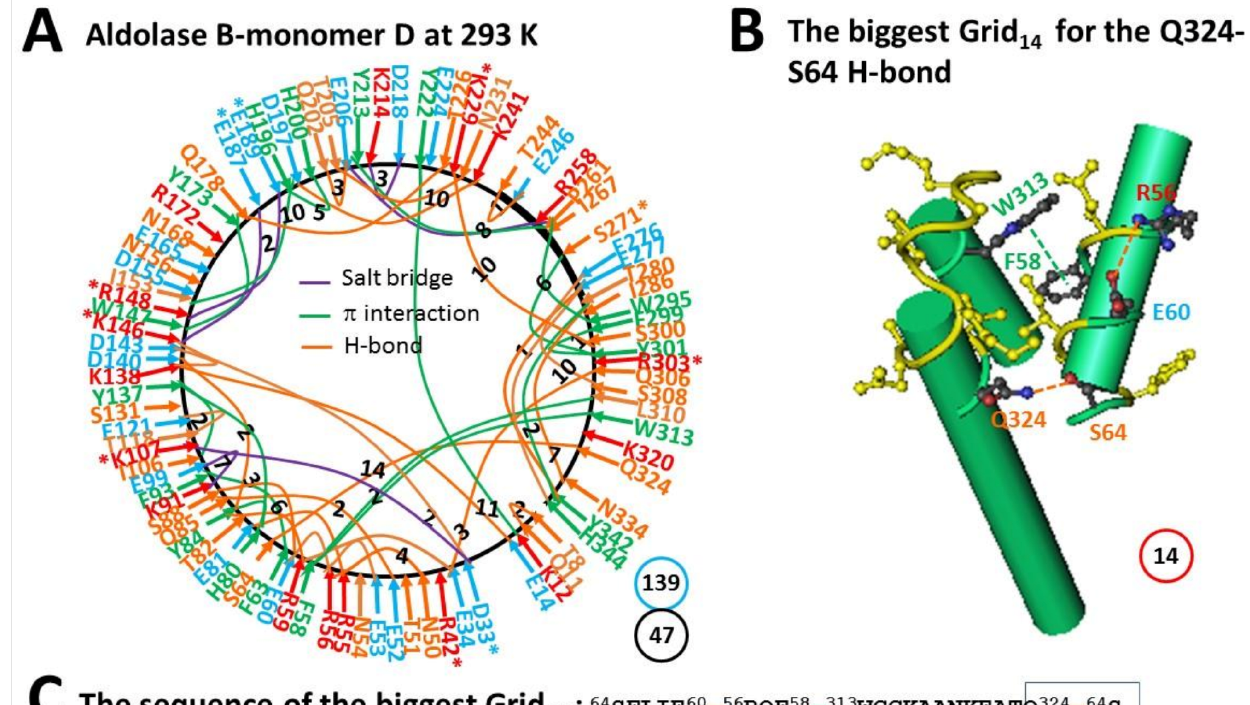
Figure 5. The grid-like non-covalently interacting mesh network along the single polypeptide chain of ligand-free monomer D in the aldolase B tetramer at room temperature (293 K). ( A ) The topological grids in the systemic fluidic grid-like mesh network. The X-ray crystallographic structure of monomer D in aldolase B at room temperature (293 K) (PDB ID, 1QO5) was used for the model [9]. Salt bridges, π interactions, and H-bonds between pairing amino acid side chains along the single polypeptide chain from Q9 to S352 are marked in purple, green, and orange, respectively. The grid sizes required to control the relevant non-covalent interactions were calculated and labeled in black. The total grid sizes and grid size-controlled non-covalent interactions along the single polypeptide chain are shown in the blue and black circles, respectively. ( B ) The structure of the biggest Grid 14 . The grid size is shown in a red circle. ( C ) The sequence of the biggest Grid 14 to control the S64-Q324 H-bond in a blue